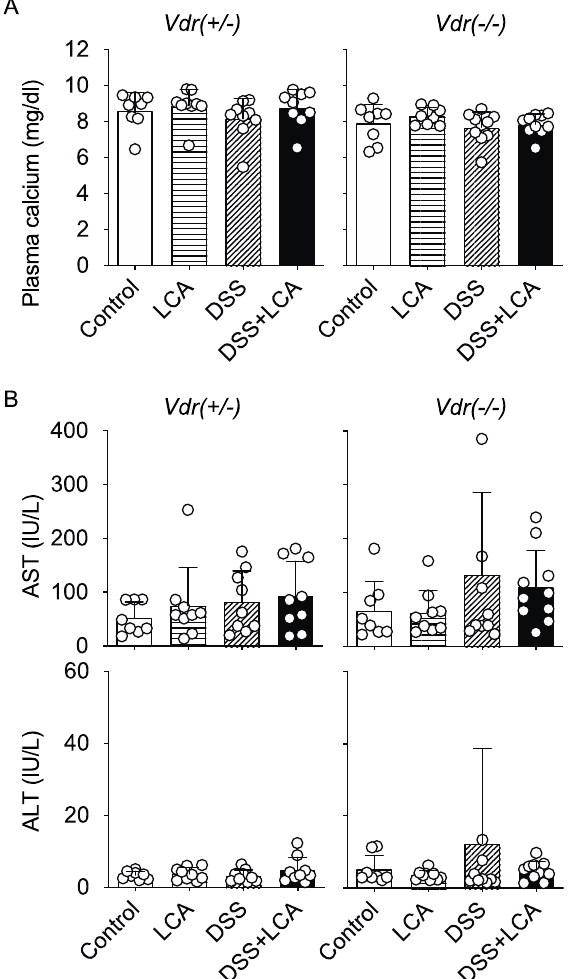
Figure 6. Oral LCA administration does not increase plasma calcium, aspartate aminotransferase, or alanine aminotransferase levels. ( A ) Plasma calcium levels. ( B ) Plasma levels of aspartate aminotransferase (AST) and alanine aminotransferase (ALT). Blood samples were collected at day 6, as shown in Figure 3A. Data are presented as means ± S.D.